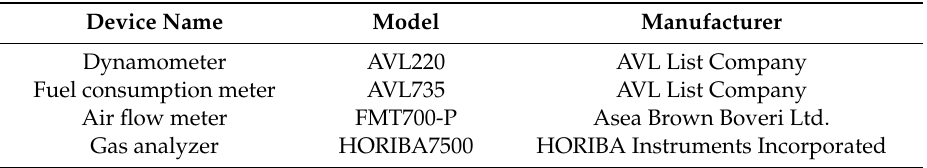
Table 5. Measurement Equipment.